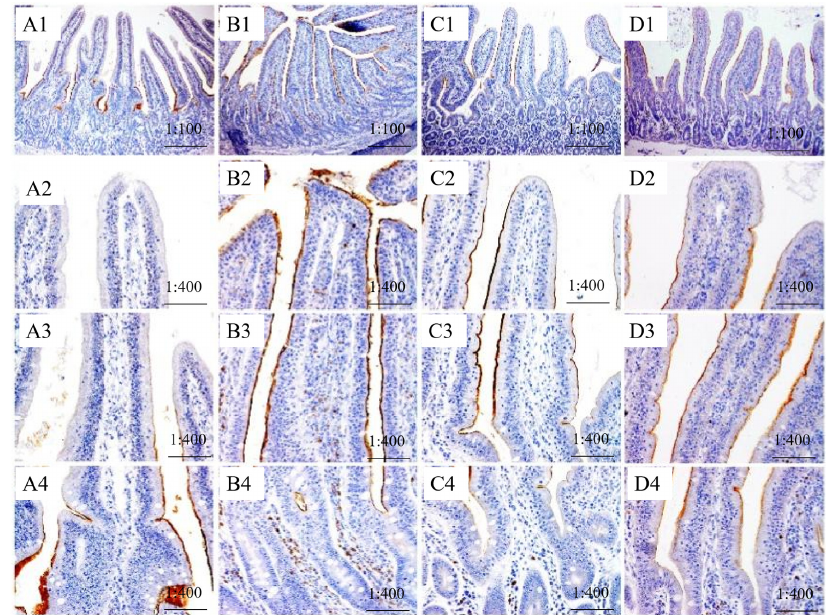
Figure 2. Effect of probiotics with added glucose oxidase (PGO) and Illicium verum extracts (IVE) on the immune positive distribution of Sodium/Glucose Cotransporter 1 (SGLT1) in jejunum of weaned piglets. Treatment 1 was fed with basal diet (IVE-PGO−, ( A1 – A4 )), and treatments 2, 3, and 4 were fed the basal diet supplemented with 1000 mg/kg PGO (IVE-PGO+, ( B1 – B4 )), 500 mg/kg IVE (IVE + PGO−, ( C1 – C4 )), and 500 mg/kg IVE + 1000 mg/kg PGO (IVE + PGO+, ( D1 – D4 )), respectively.